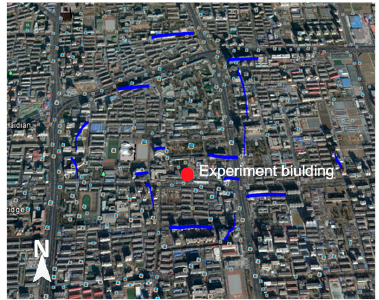
Figure A3. Possible coming area of RFI.